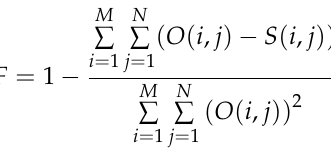
Image Fidelity: Image Fidelity (IF) is given Equation (3). For the two same images, the image fidelity is one. The image fidelity closer to one indicates less distortion from the cover image.